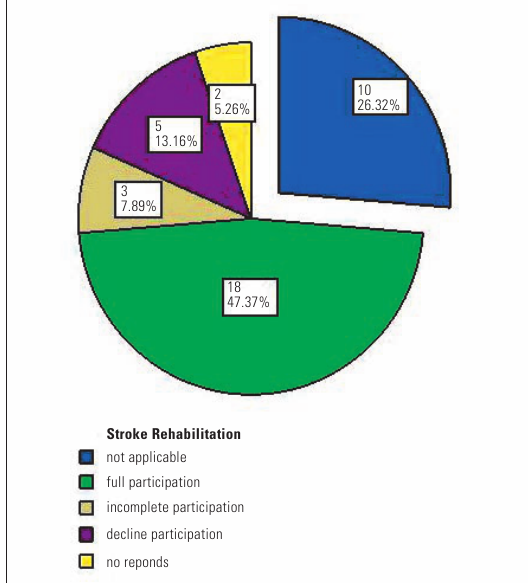
Figure 1 Distribution of facilities inquired (n =